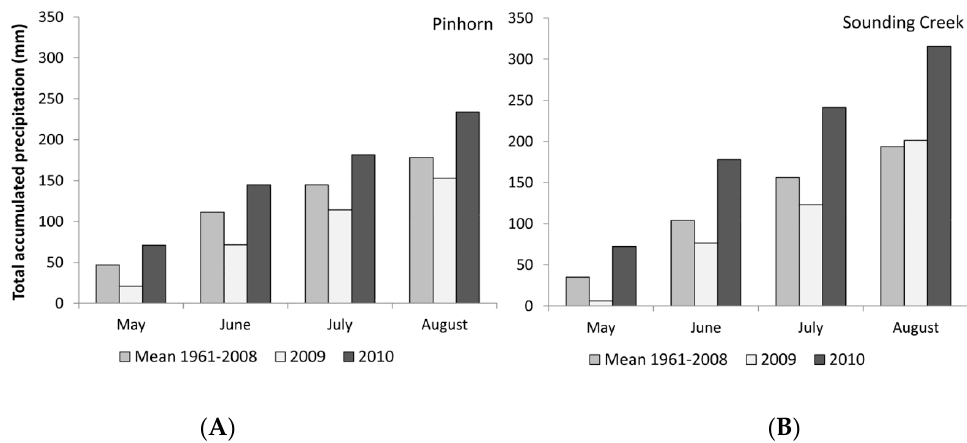
Figure 4. Comparison of the normal accumulated precipitation (mean calculated over 1961 to 2008) to the accumulated precipitation measured at the Pinhorn grazing reserve ( A ) and the Sounding Creek grazing reserve ( B ) in the 2009 and 2010 growing seasons. The meteorological data are courtesy of Alberta Agriculture and Forestry.